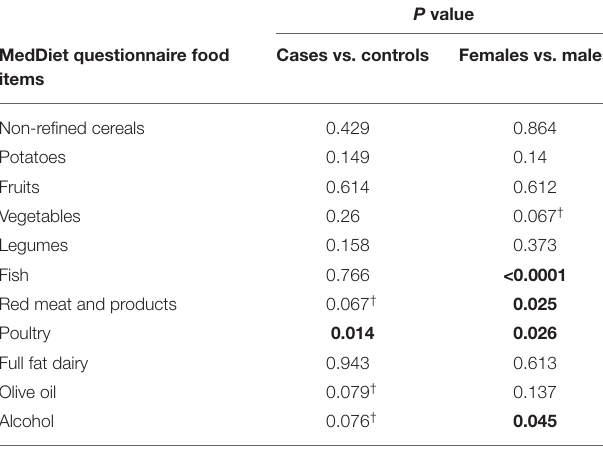
P value MedDiet questionnaire food Cases vs. items